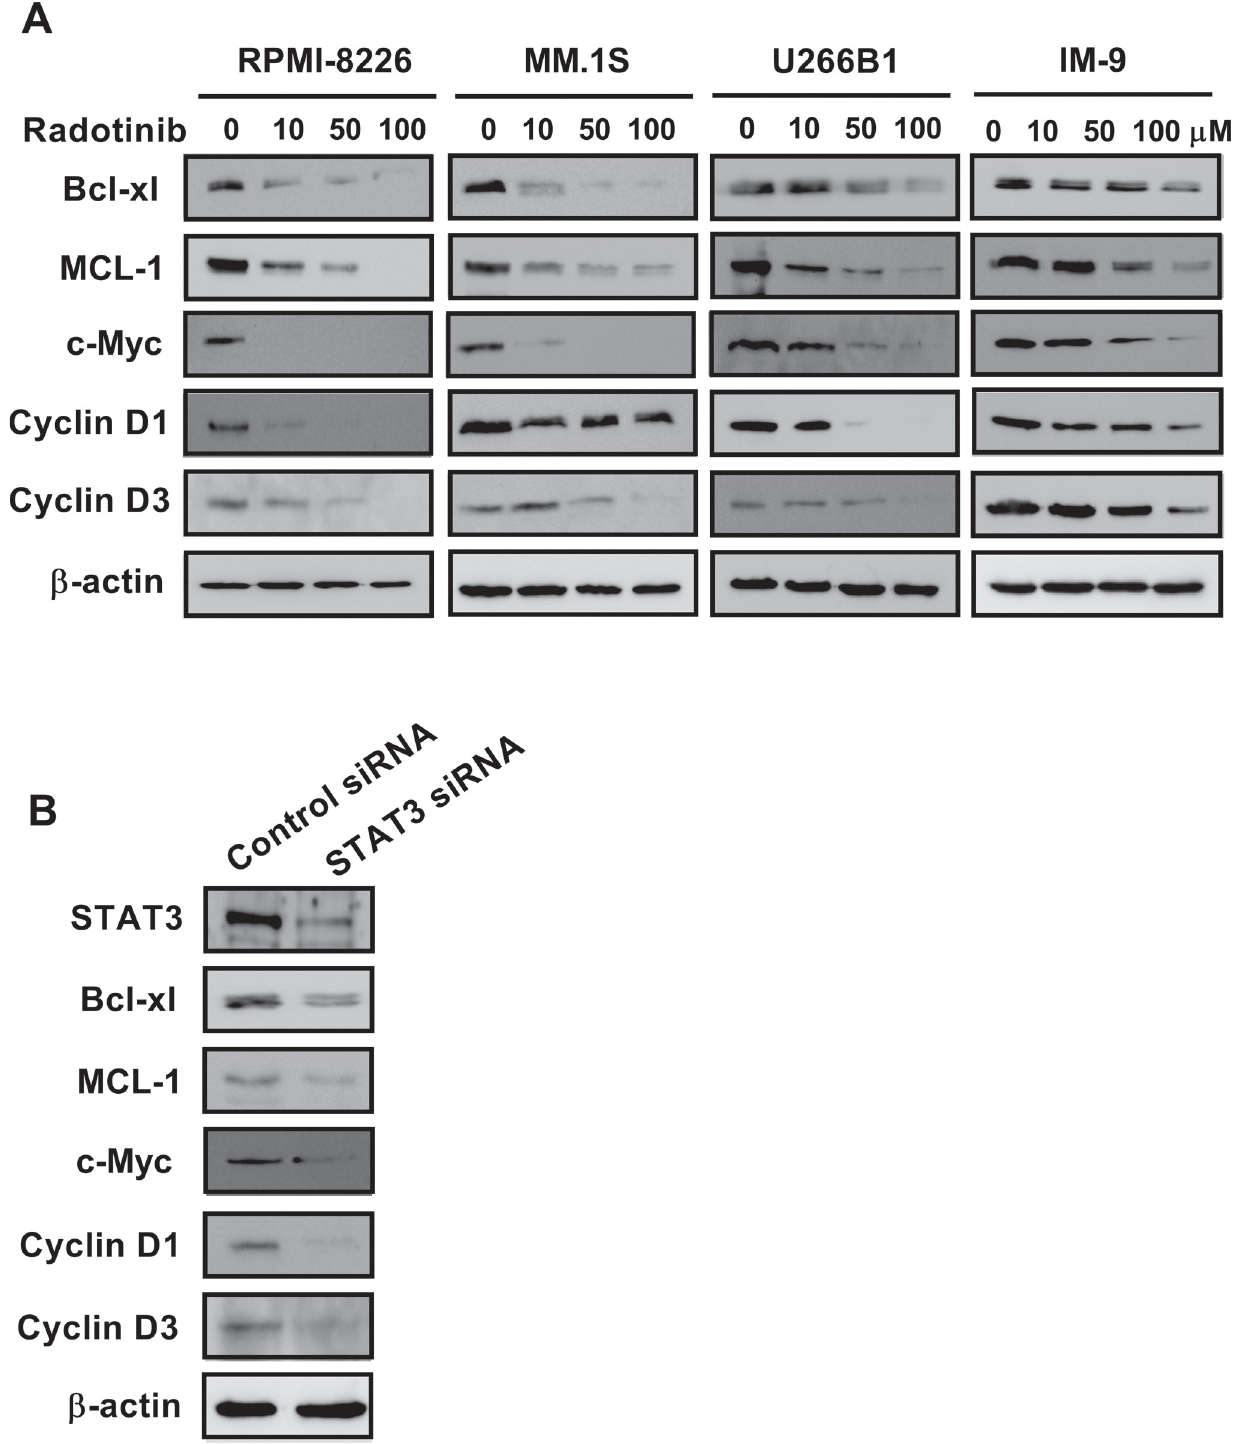
Fig 4. Radotinib strongly inhibits the activity and expression of STAT3 and JAK2 in various MM cells. (A) Effects of radotinib on the downstream proteins of STAT3 including expression of Bcl-xL, Mcl-1, c-Myc, cyclin D1, and cyclin D3. (B) Effects of STAT3 siRNA on MM cell proliferation. The membrane was stripped and reprobed with anti- β -actin mAb to confirm equal